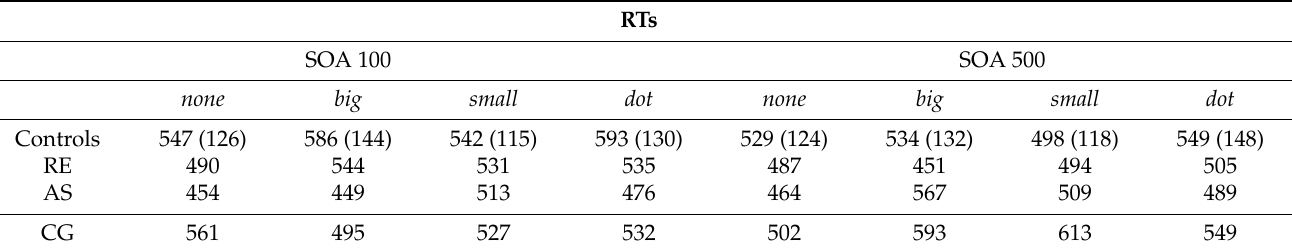
Table 3. Mean reaction times (and standard deviations) for controls and the three patients in the cueing task by SOA and Cue conditions.